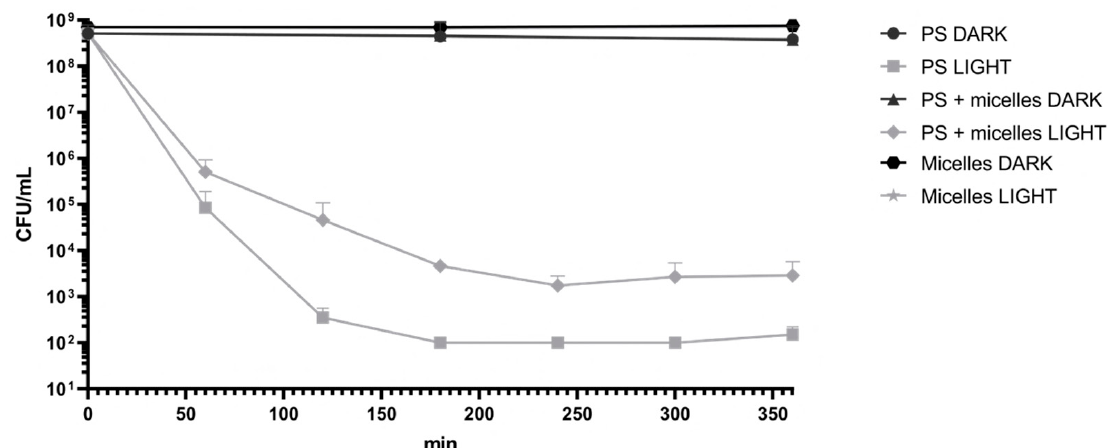
Figure 5. Photodynamic inactivation of Staphylococcus aureus with 0.1 μ M BODIPY dissolved in DMSO or encapsulated in micelles. The irradiation with light at 520 nm was delivered up to 6 h, and the effect of micelle-encapsulated BODIPY and of BODIPY was checked every 60 min. Cell viability of control samples was checked upon 3 and 6 h of dark incubation or